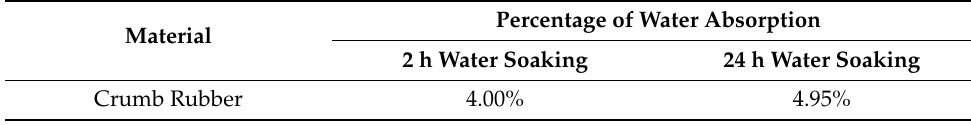
Table 4. Crumb rubber water absorption/adsorption at 2 h and 24 h.